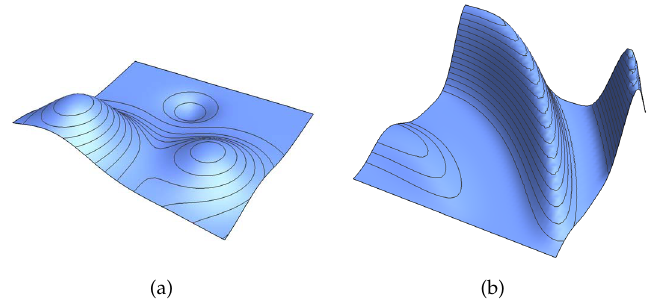
Figure 14. Plots of the tests functions: Franke ( a ) and Nielson ( b ).